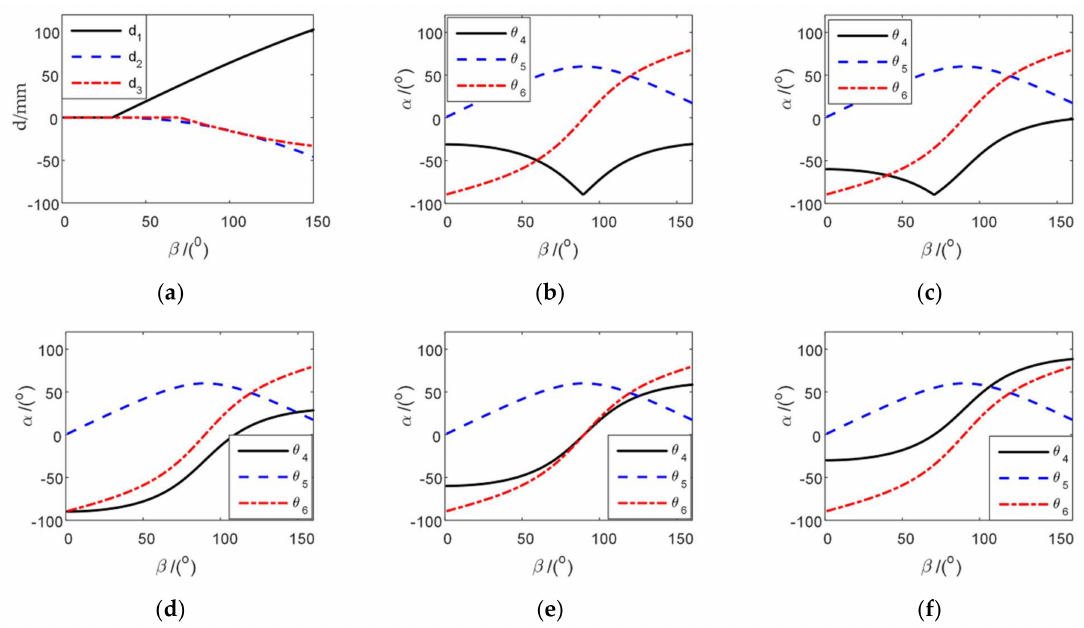
Figure 10. Changes in the motion parameters in the 0 ◦ , 30 ◦ , 60 ◦ , 90 ◦ and 120 ◦ lifting planes. ( a ) The lift angle corresponds to the translation distance of the moving pair; ( b ) the rotational angle of each joint in the lifting plane 0 ◦ ; ( c ) the rotational angle of each joint in the lifting plane30 ◦ ; ( d ) the rotational angle of each joint in the lifting plane 60 ◦ ; ( e ) the rotational angle of each joint in the lifting plane 90 ◦ ; ( f ) the rotational angle of each joint in the lifting plane 120 ◦